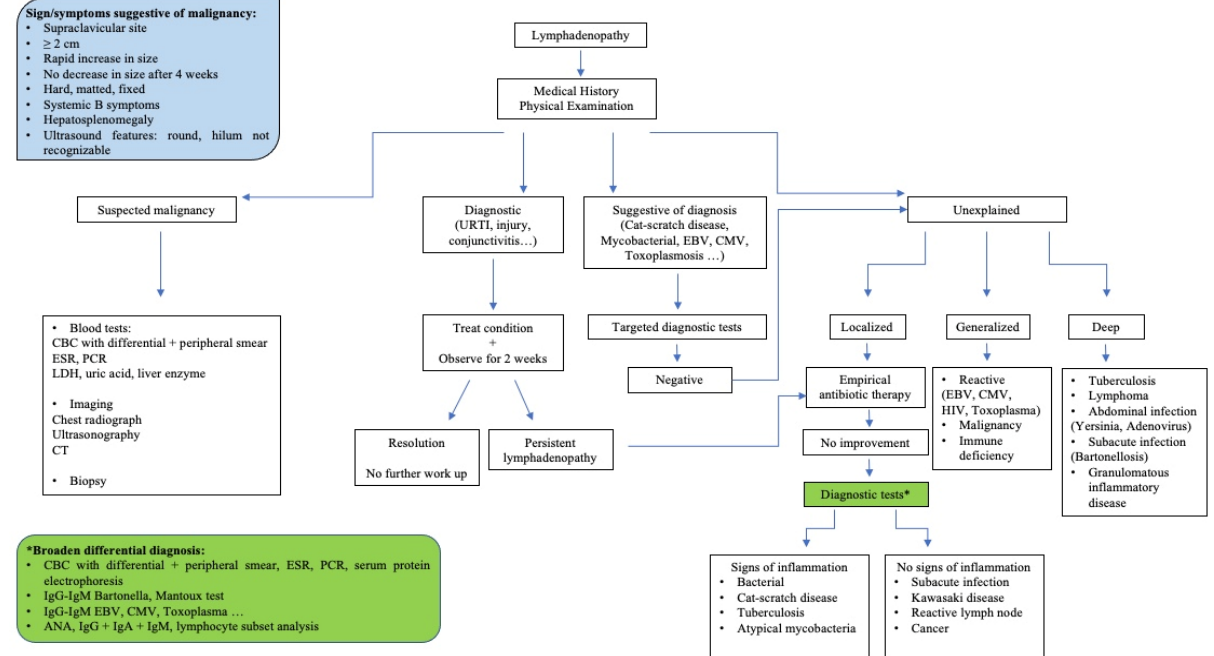
Figure 1. A proposed diagnostic and therapeutic approach to lymphadenitis in children. ANA, anti-nuclear antibodies; CBC, cell blood count; CT, computed tomography; CMV, cytomegalovirus; EBV, Epstein-Barr virus; ESR, erythrocyte sedimentation rate; HIV, human immunodeficiency virus; LDH, lactate dehydrogenase; PCR, C reactive protein,.